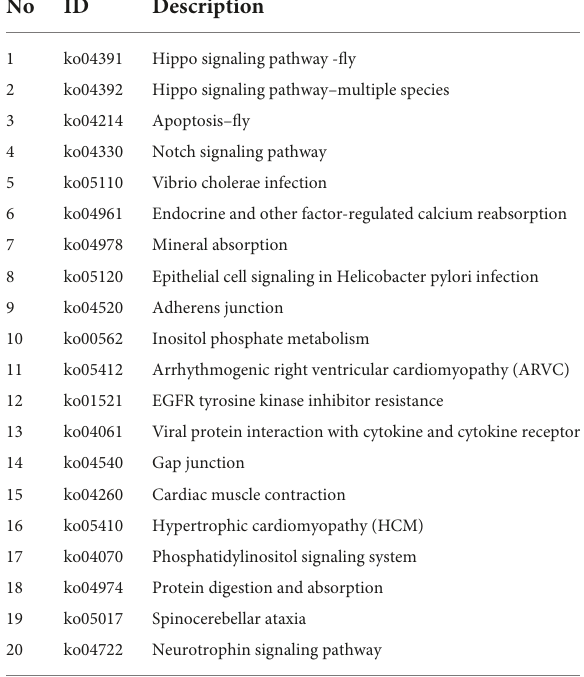
TABLE 1 Top 20 enriched kyoto encyclopedia of genes and genomes (KEGG) pathways for host genes of differentially expressed circular RNAs after rat central axon